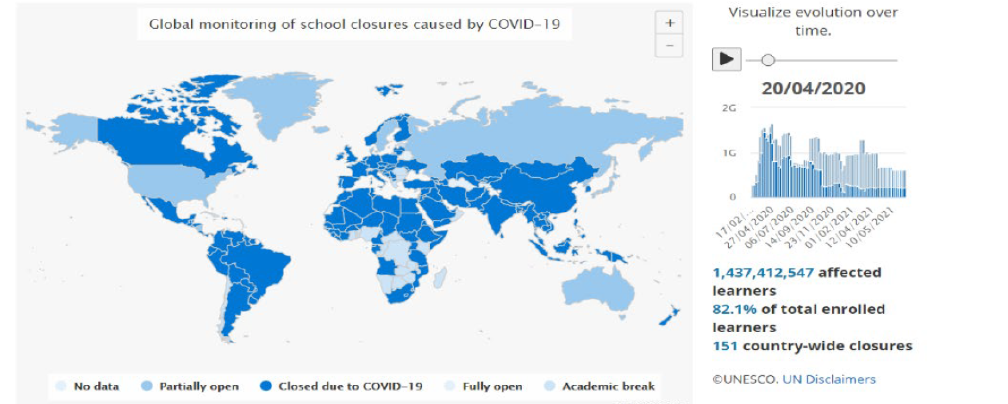
Figure 1. Global monitoring of school lockdowns affected by the COVID-19 pandemic (UNESCO report)